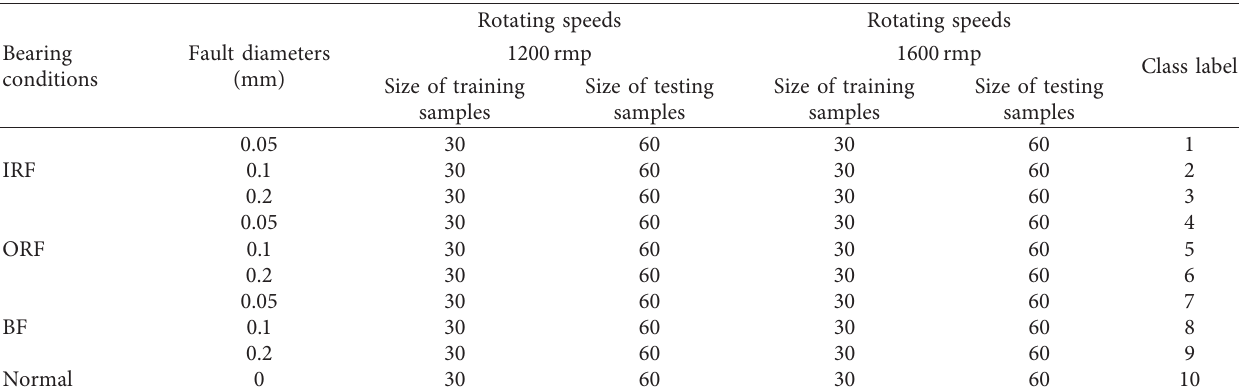
Figure 16: Comparison of fault diagnosis results of comparative models. Table 7: Details about the bearing vibration dataset.